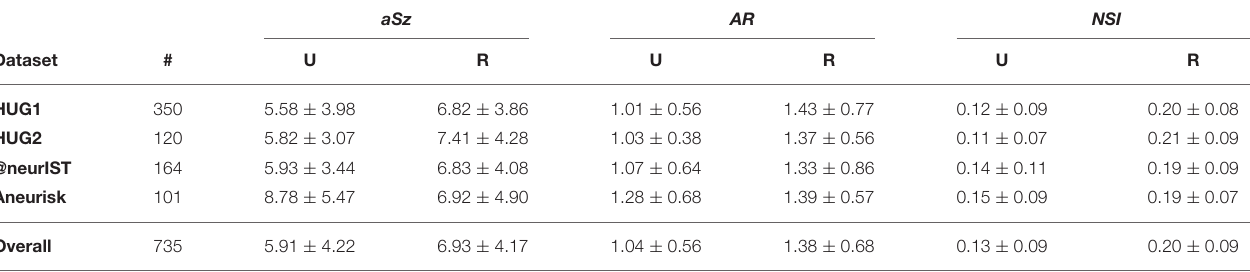
TABLE 9 | Summary statistics for the entire AneuX morpho database, stratified by dataset and rupture status.